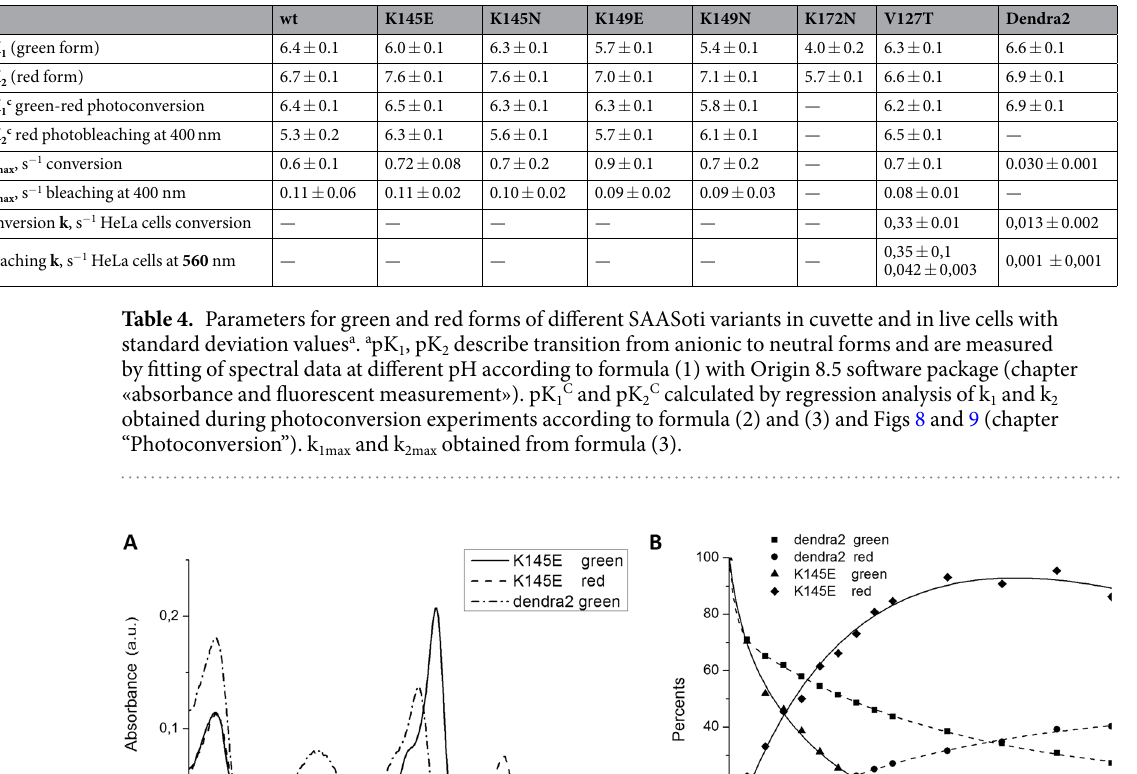
Figure 7. ( A ) Absorbance spectra of K145E (green state), K145E (red state) and Dendra2 (green state) in Tris- HCl pH 7.5. ( B ) Kinetics of the green-to-red photoconversion of the fluorescence of the K145E mutant and Dendra2 upon irradiation with a 405 nm laser. (Dendra2 green excitation (ex.) 465 nm, emission (em.) 507 nm, red ex. 530 nm, em. 573 nm, K145E green ex. 475 nm em. 519 nm, red ex. 550 nm, em. 590 nm all with 5 nm slits).